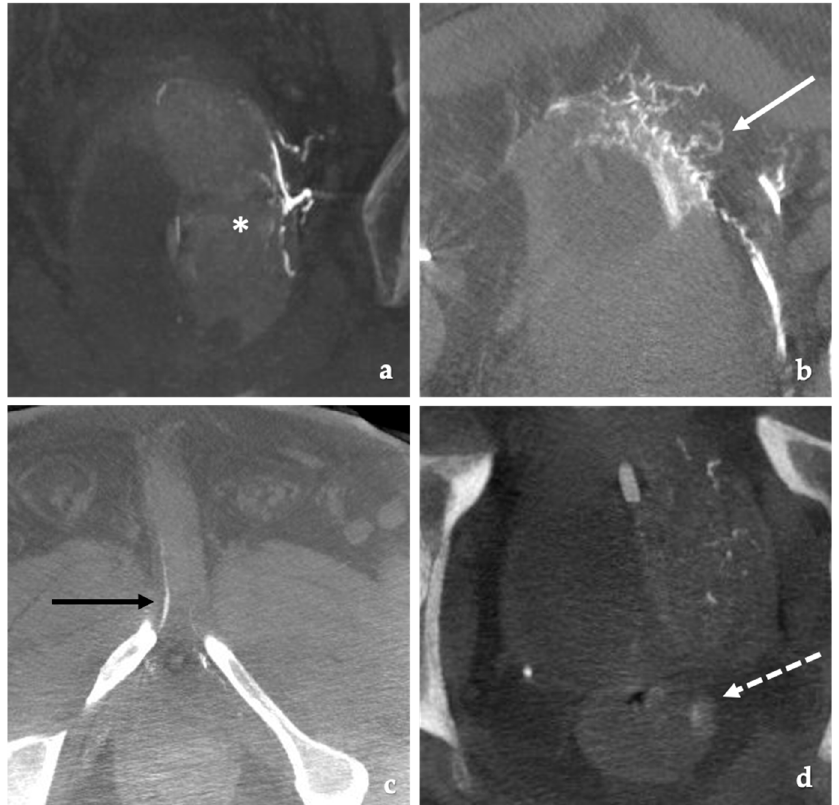
Figure 2. Examples of cone beam CT demonstrating target and non-target embolization. ( a ) Coronal reconstruction from a cone beam CT acquisition. Appropriate contrast enhancement of the left hemiprostate (white asterisks) with contrast injection of the left prostatic artery. ( b ) Axial cone beam CT image. Non-target filling of the bladder (white arrow). Foley catheter balloon in the bladder. ( c ) Axial cone beam CT image. Non-target filling of the penile artery (black arrow). ( d ) Axial cone beam image. Non-target enhancement of the rectum (dotted white arrow) with contrast enhancement of the prostate.